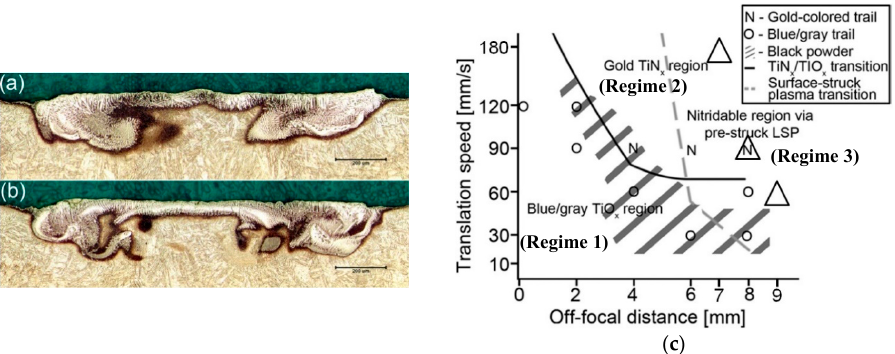
Figure 5. Optical micrograph of transverse cross-section of titanium nitrided ( a ) using a LSP, and ( b ) without a LSP (i.e., only the laser beam) at otherwise identical processing conditions; ( c ) processing window of Nassar et al. [108] showing different regimes during LSP nitriding of pure titanium, where the triangles represent processing conditions used by Kamat et al. [109] to compare laser nitriding in the presence and absence of the nitrogen LSP. The scale bars in ( a ) and ( b ) read 200 µm. Reprinted with permission from Ref . [108]. Copyright 2012 IOP Publishing.